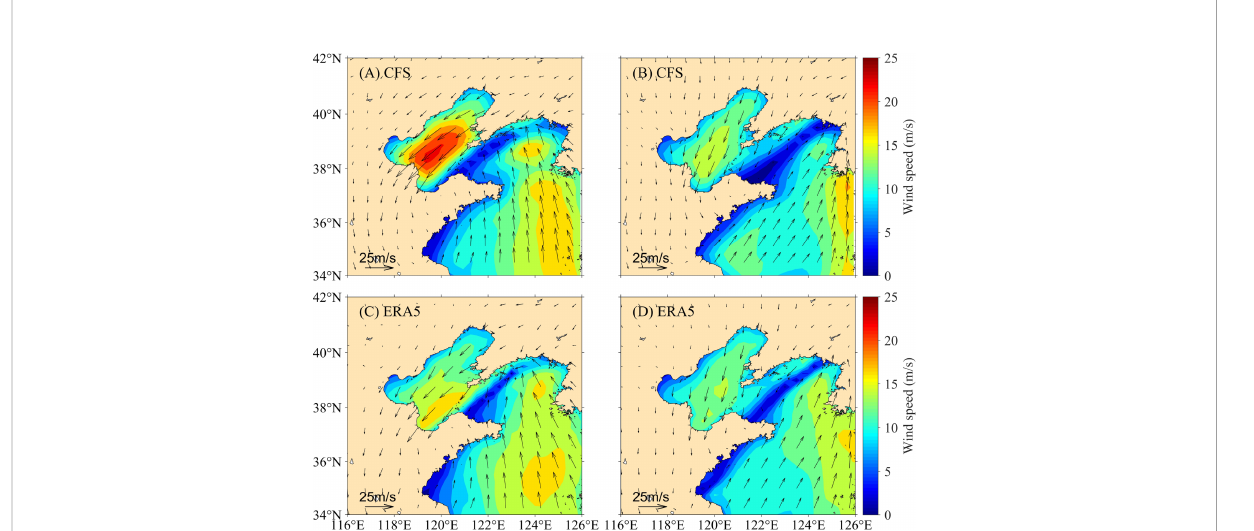
FIGURE 2 Comparisons of wind fi eld snapshots between CFS and ERA5 at 12:00 (UTC) on September 1, 1992 (A, C) and at 18:00 (UTC) on September 1, 1992 (B, D) during